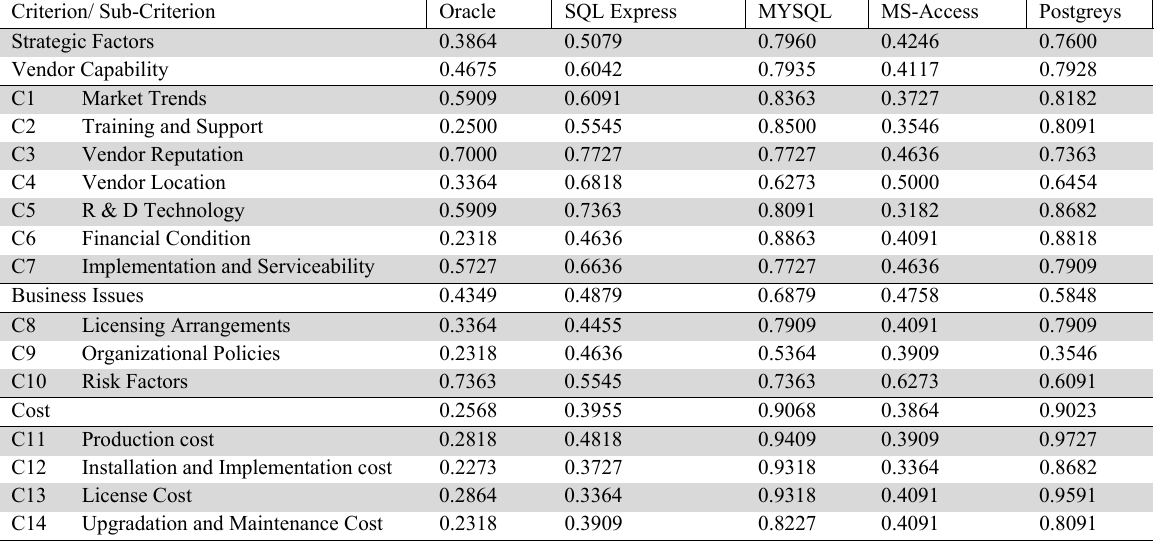
Table 2 Aggregated average performance ratings of DBMS COTS components Criterion/